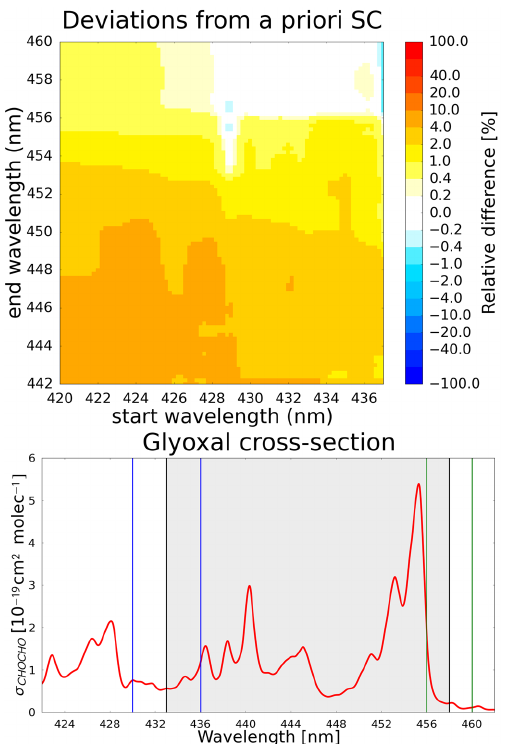
Figure 1. Colour mapping of the relative difference of CHOCHO SCs with respect to the a priori (“true value”) (cid:17) (cid:16) SC × 100 fitted − SC true retrieved from a synthetic spectrum for SC true wavelength intervals with start limits of 420–437nm and end lim- its 442–460nm (top). Glyoxal absorption cross-section at 296K (Volkamer et al., 2005b); blue and green lines mark the start and end of the favourable wavelength intervals, respectively, with the main absorption bands in the shaded area (bottom).